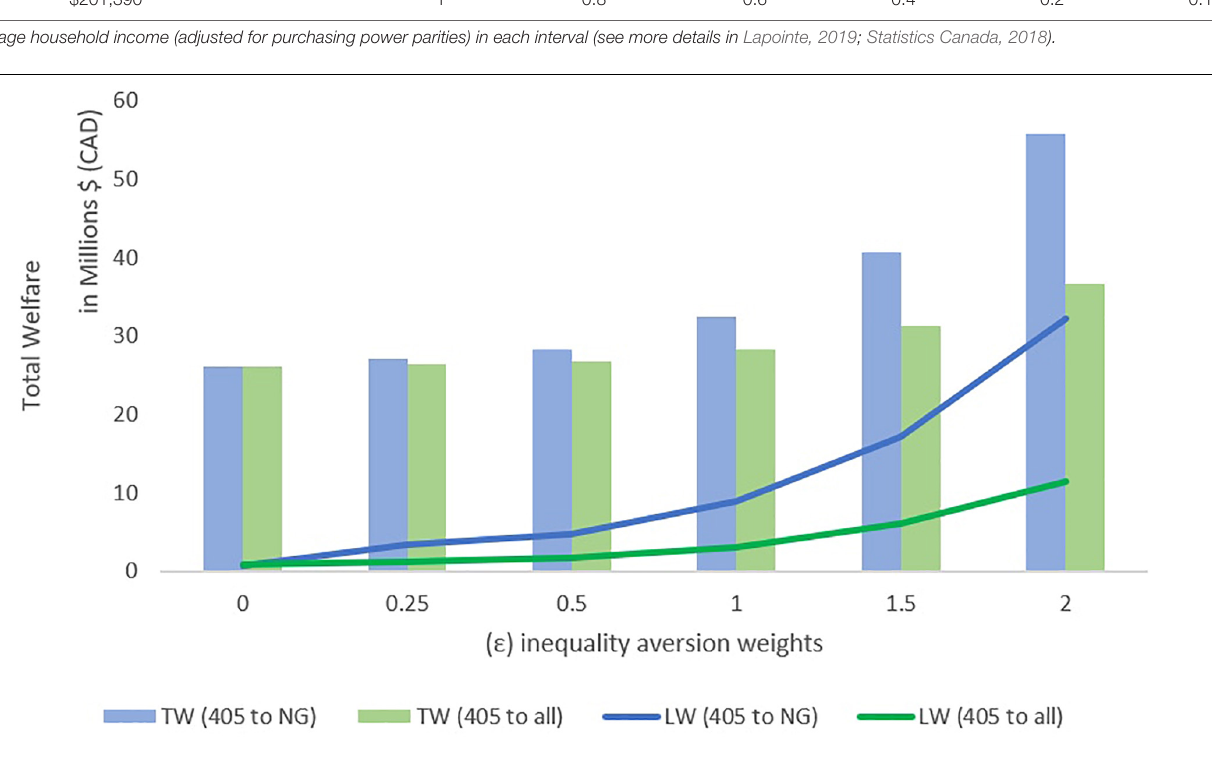
FIGURE 4 | Local welfare (LW), in lines, and Total welfare (TW), in columns, produced from the turbot 2+3KLMNO fishery under varying inequality aversion weights for scenarios B-II (in green, distribution of TAC increase to all stakeholders) and B-IV (in blue, distribution of TAC increase to the NG